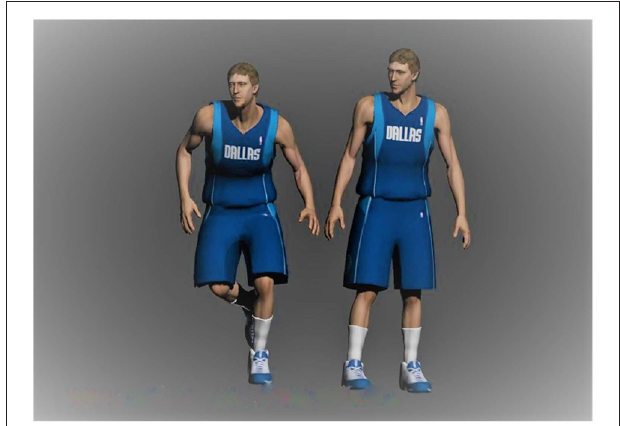
FIGURE 6 | The model of 3dMax basketball